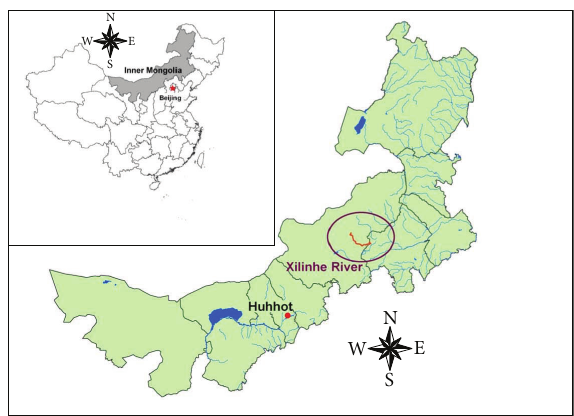
Figure 1: Location of Xilin River in Inner Mongolia, China.